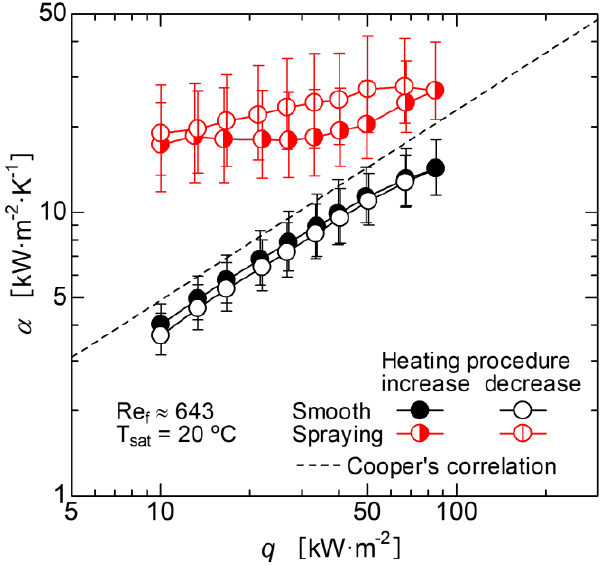
ffi cients on smooth and sprayed coated